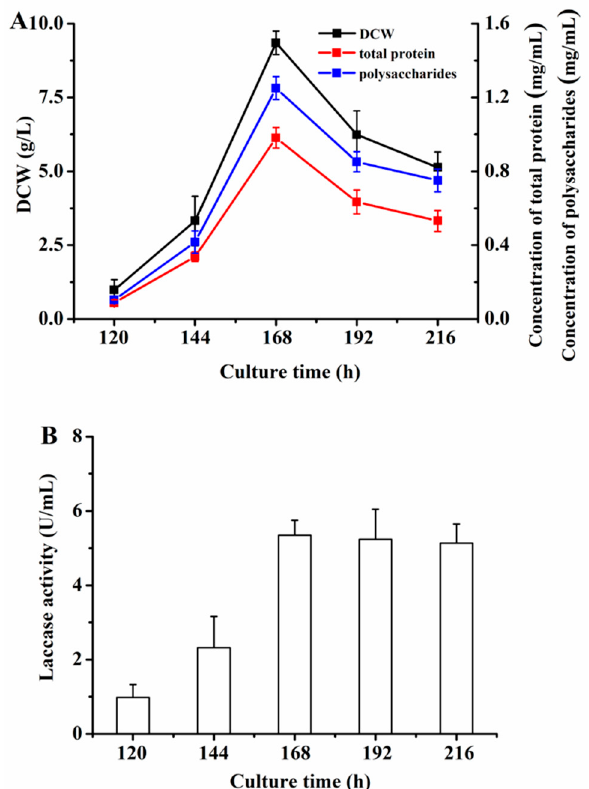
Figure 3. The effect of the culture time of P. eryngii -3 in the shake flask. ( A ) The effect on the DCW, total protein, and polysaccharides; ( B ) The effect on laccase activity. Data points are the average of n = 3; error bars represent the standard error of the mean. The samples were harvested at 120 h, 144 h, 168 h, 192 h, and 216 h of fermentation.